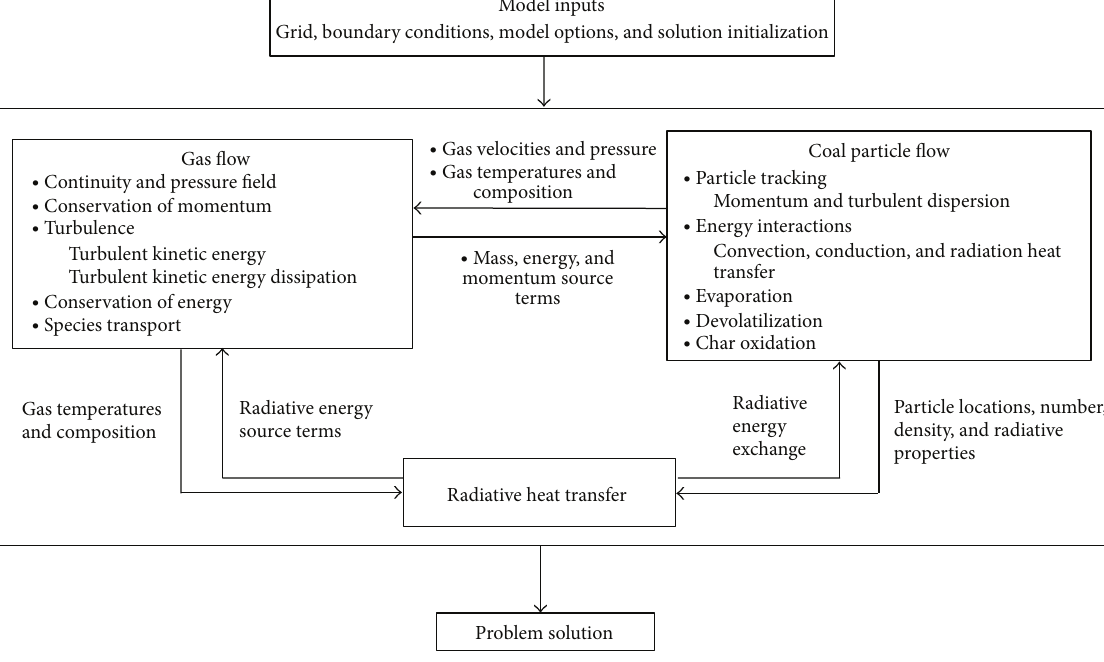
Figure 7: CFD model